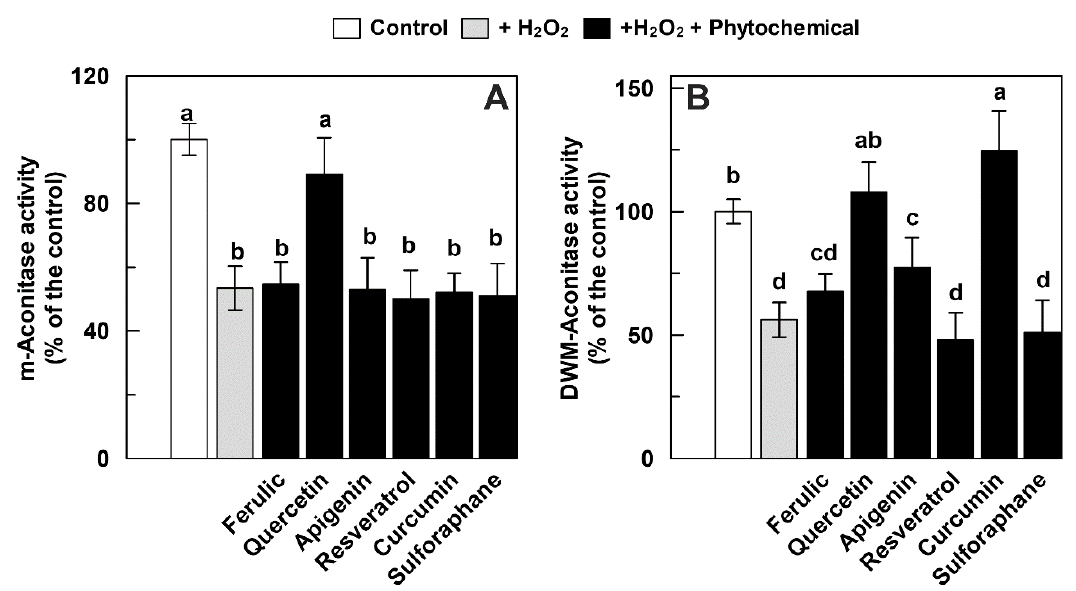
Figure 6. Recovery effect of different phytochemicals on m-aconitase ( A ) and DWM-aconitase ( B ) activities treated with H 2 O 2 . Measurements were carried out as described in Methods by treating m-aconitase (250 µg) for 15 min with 750 µM H 2 O 2 ( A ) and DWM (150 µg) with 500 µM H 2 O 2 ( B ) and in the last 5 min of incubation, the different phytochemicals were added at 150 µM (75 µM in the case of resveratrol). Activity values are expressed as a percentage of the control (i.e., the reaction measured at time 0 in the absence of both H 2 O 2 and phytochemicals) and reported as the mean value ± SD ( n = 3). Means with no lowercase letter in common are statistically different at a 0.05 p level of significance, according to the post hoc Duncan’s test, following ANOVA. Means with at least one common lowercase letter a–d are not significantly different at p ≤ 0.05. In this set of experiments, m-aconitase and DWM-aconitase activities under control conditions were equal to 18 ± 1 and 30 ± 2 (SD, n = 3) nmol ∙ min − 1 ∙ mg − 1 of protein, respectively.